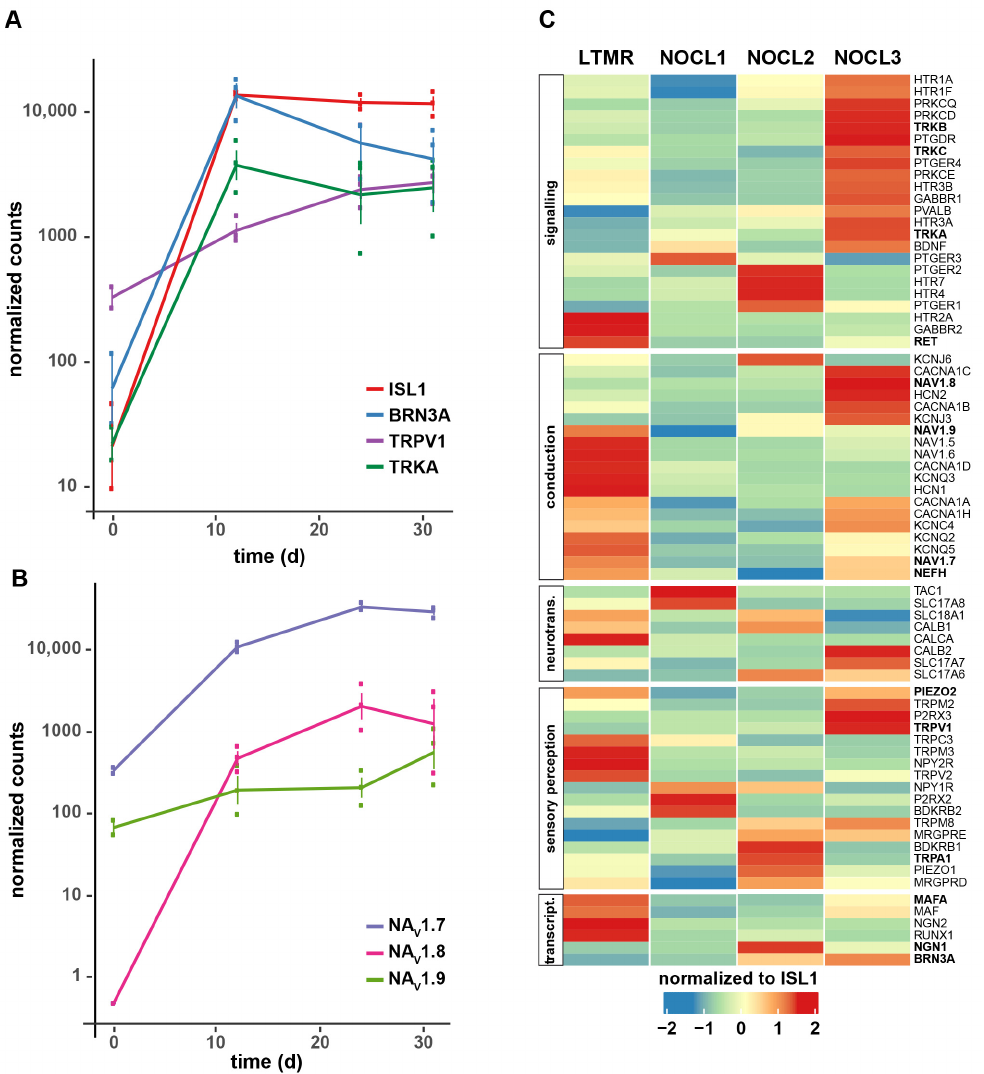
Figure 3. ( A ) RNA–seq analysis of ISL1, BRN3A, TRPV1 and TRKA transcripts in NOCL3 cells at specific time points during their differentiation (0, 12, 24 and 31 d), shown as normalized counts (for analysing details see material and methods; n = 3). ( B ) RNA–seq analysis of NA V 1.7, NA V 1.8 and NA V 1.9 transcripts in NOCL3 cells at specific time points (0, 12, 24 and 31 d) during their differentiation, shown as normalized counts ( n = 3). ( C ) Heatmap showing the relative expression of selected genes in LTMR and NOCL1–3 cells after 24 days of differentiation. Genes are categorized into functionally connected groups, and those indicated in bold have been analysed in more detail (neurotrans. = neurotransmission, transcript. = transcription). Gene counts were first normalized and then related to the pan–sensory marker ISL1 and averaged ( n = 3). Depicted are center–scaled